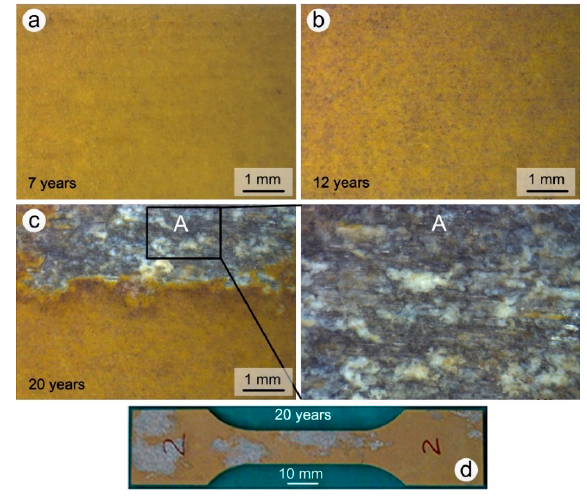
Figure 4. Surface appearance of coated test specimens exposed to the Wanning test site: ( a ) 7 years; ( b ) 12 years; ( c ) 20 years; ( d ) 20 years (whole upper surface).